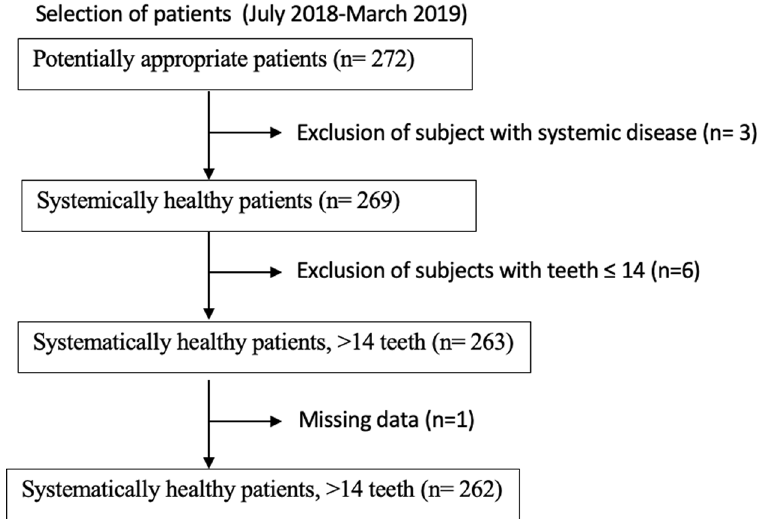
Figure 1. Flow diagram of the